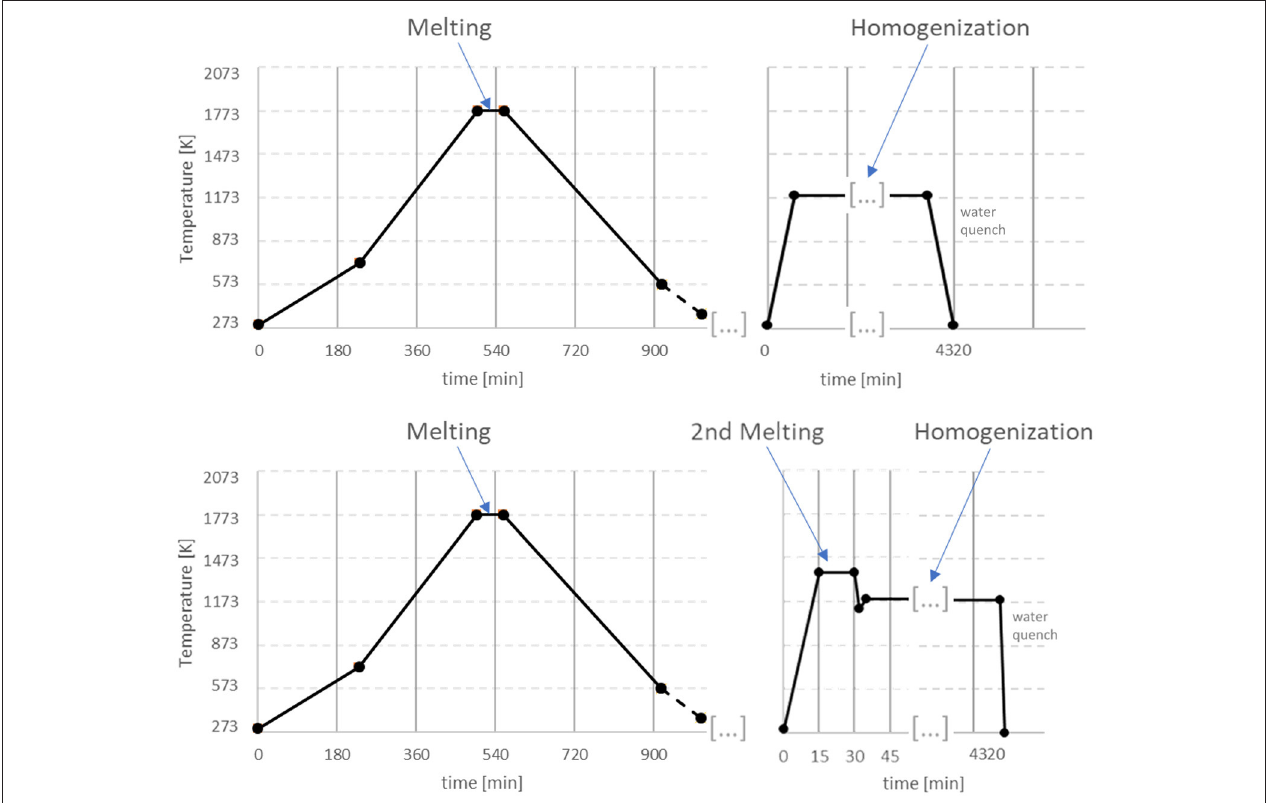
FIGURE 1 | Cartoon summarizing the synthesis protocols for group A ( top panel ) and group B ( bottom panel ) samples. Group A samples were melted once; group B samples were melted twice.